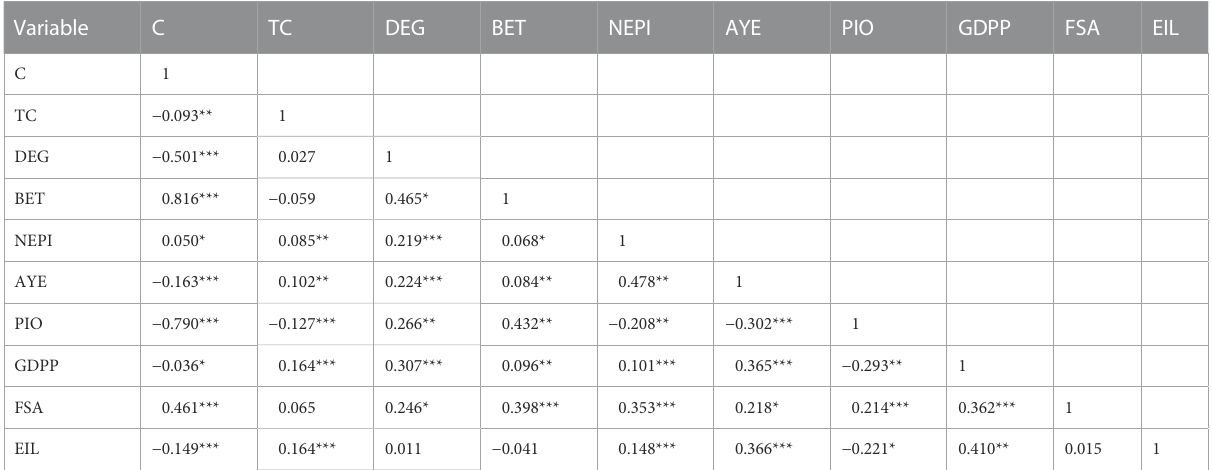
TABLE 5 Correlation test between variables.